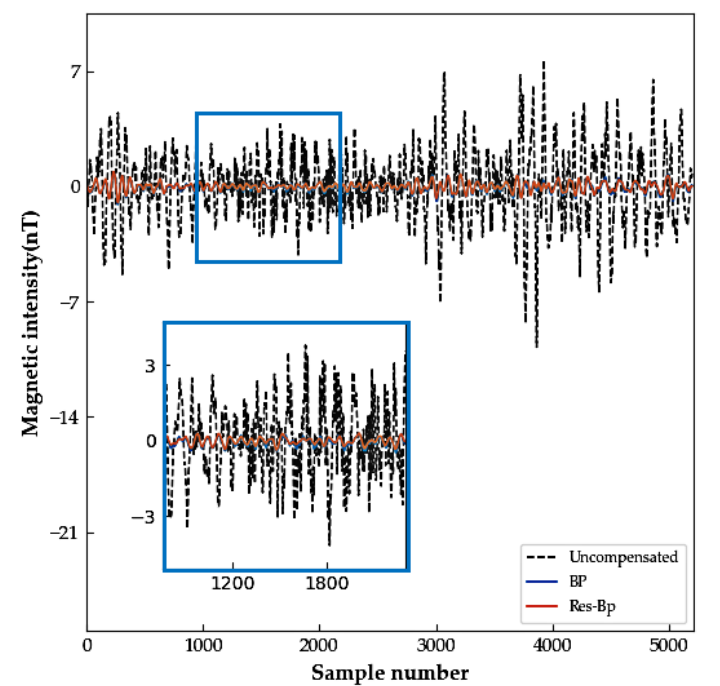
Figure 8. BP and Res-Bp compensation results for flight